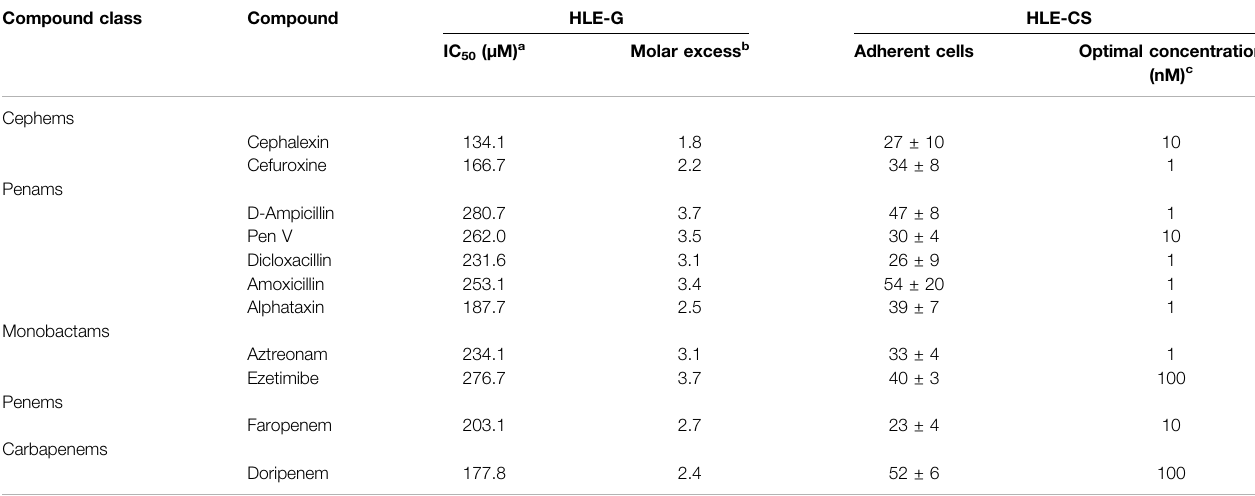
TABLE 1 | All 5 Classes of β -Lactams Bind to HLE-G and HLE-CS. Compound